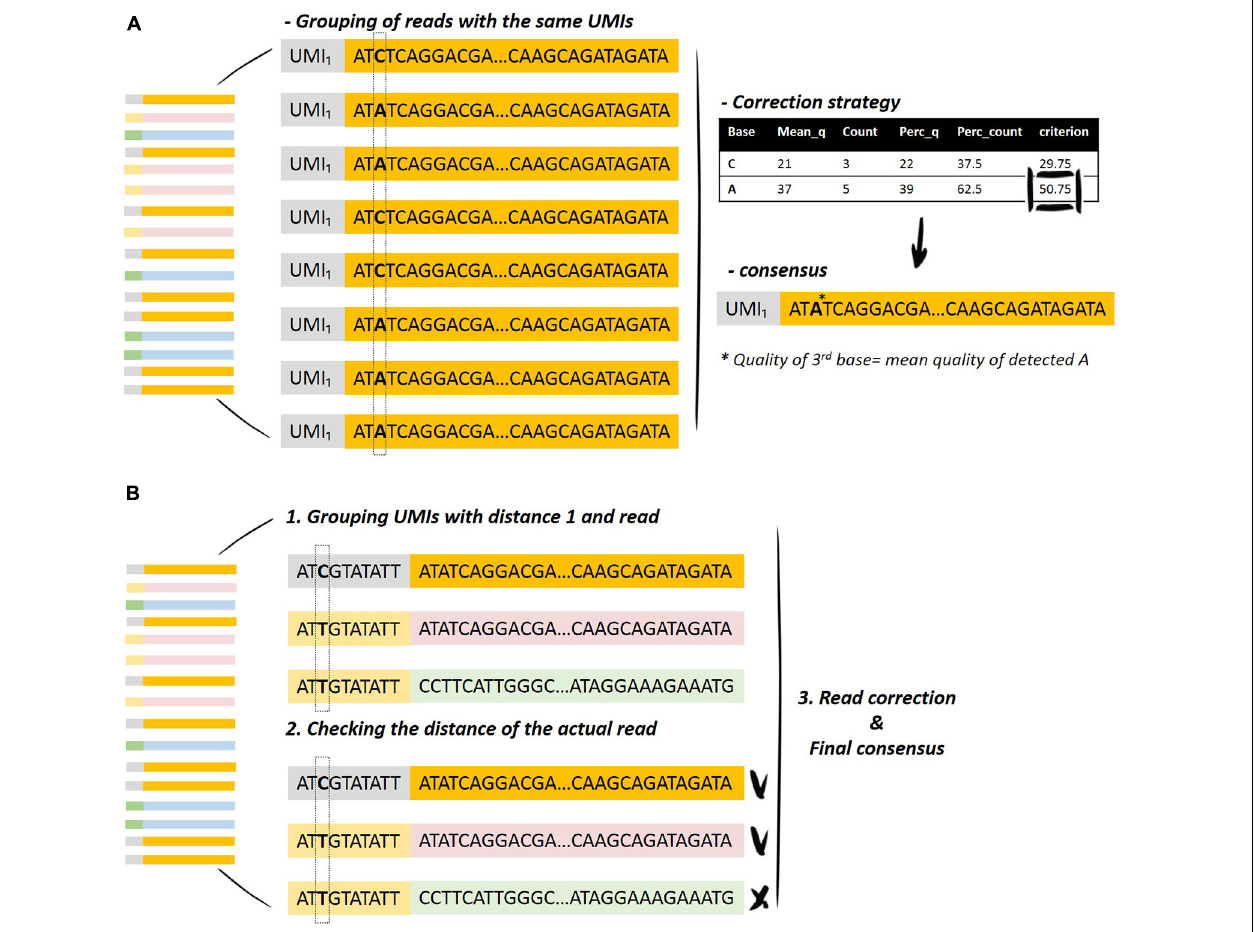
FIGURE 2 | Graphical representation of the UMI merging method. (A) Grouping of the reads with the same UMI and selection of the bases for the generation of the consensus sequence. (B) Grouping of the UMIs with specific distances and inspection of the distance of the actual read in order to merge the reads resulting from the same